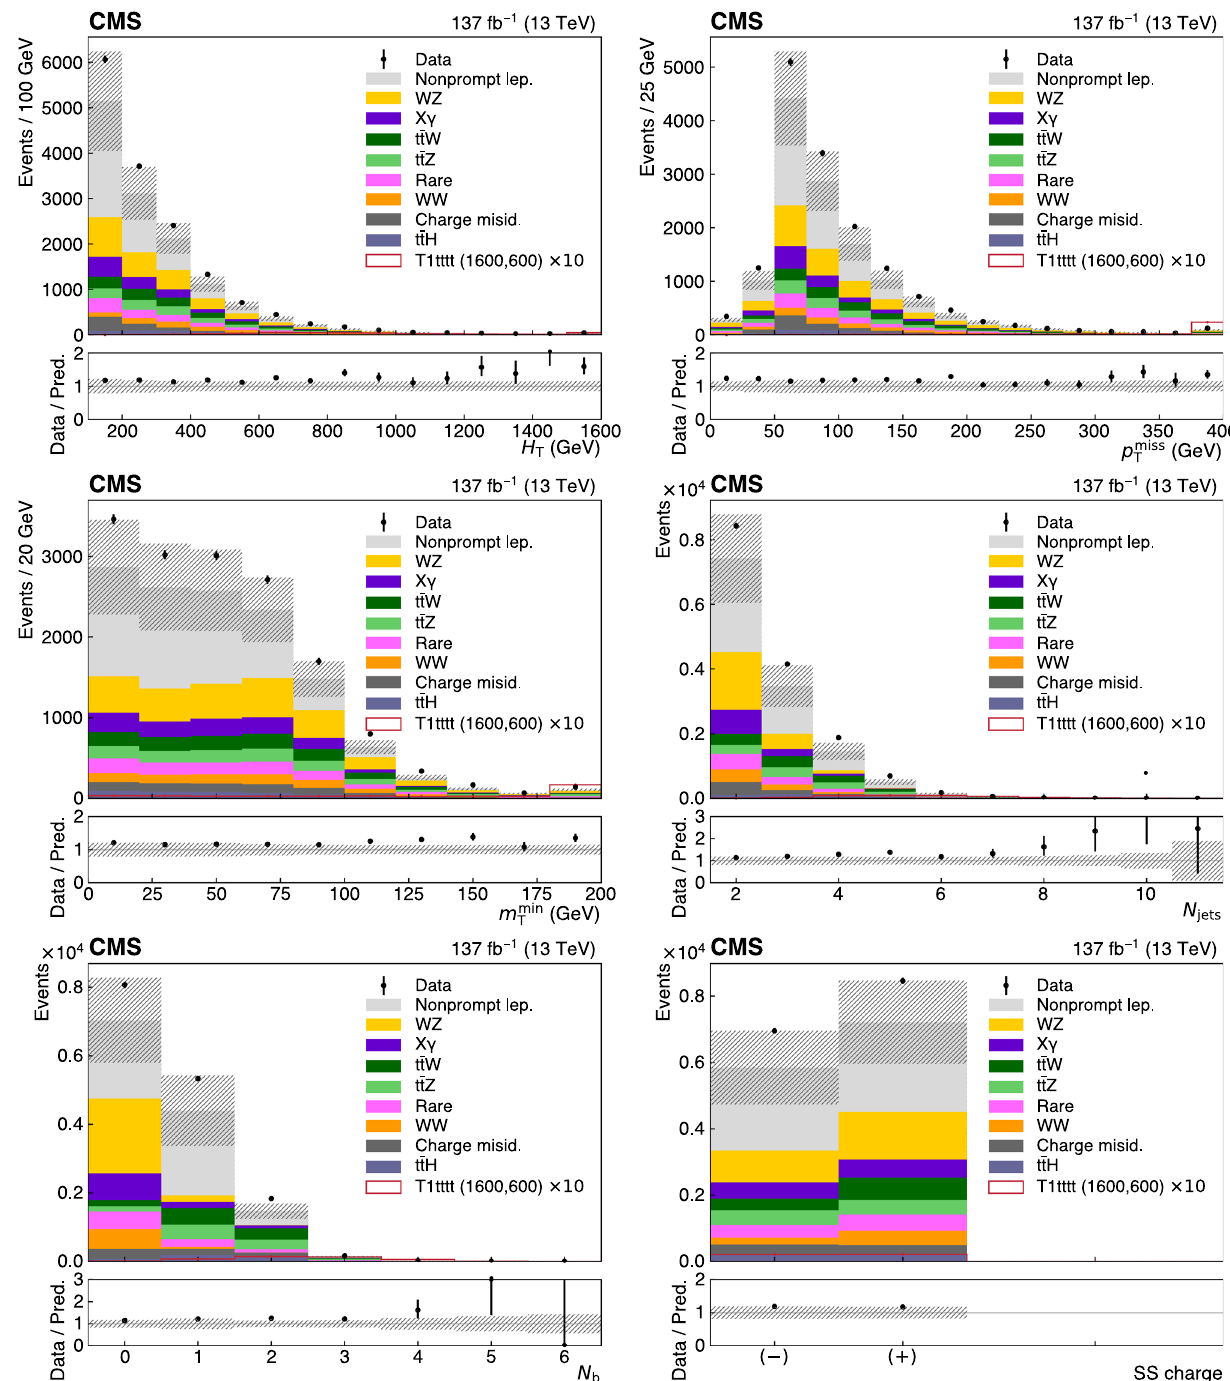
Fig. 4 Distributionsofthemainanalysisvariablesaftertheeventselec- tion: H T , p miss , m min , N jets , N b , and the charge of the SS pair, where the T T last bin includes the overflow (where applicable). The hatched area rep- resents the total statistical and systematic uncertainty in the background